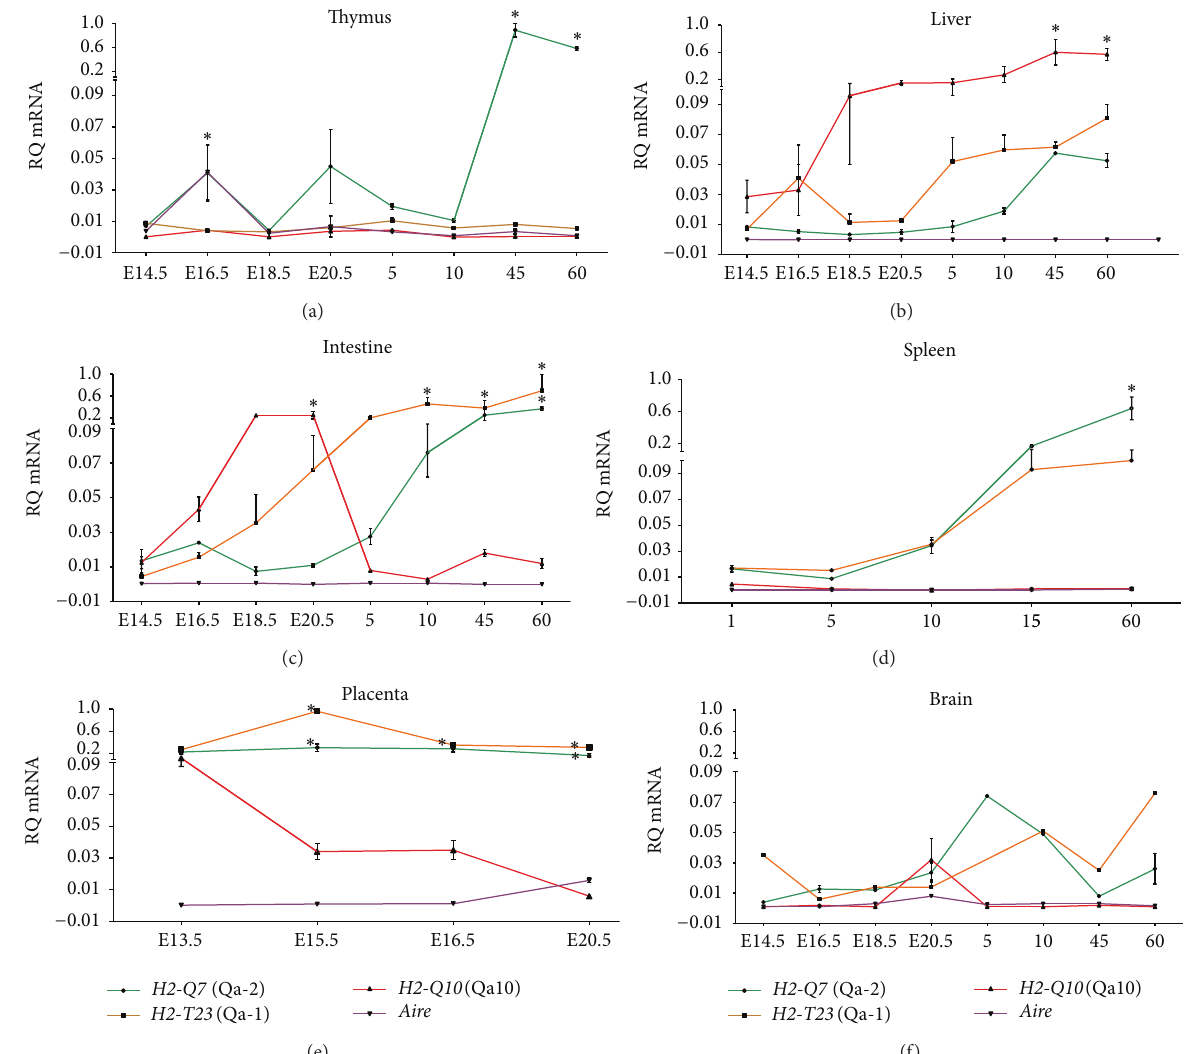
Figure 2: Comparisons of gene expression profiles of MHC class Ib and Aire during development of thymus, lymphoid, and nonlymphoid tissues in C57BL/6 mice. Relative quantification (RQ) obtained from (a) thymus, (b) liver, (c) intestine, (d) spleen, (e) placenta, and (f) brain is representative of the mean values of 2 −ΔΔ Ct . obtained from comparisons of the four genes in each tissue independently. Tissue samples were obtained in triplicate from different animals for each age analyzed. Each experiment was independently performed at least three times. Data were analyzed statistically by two-way ANOVA followed by the Bonferroni multiple comparison test. Values close to the level of significance are marked with ( ∗